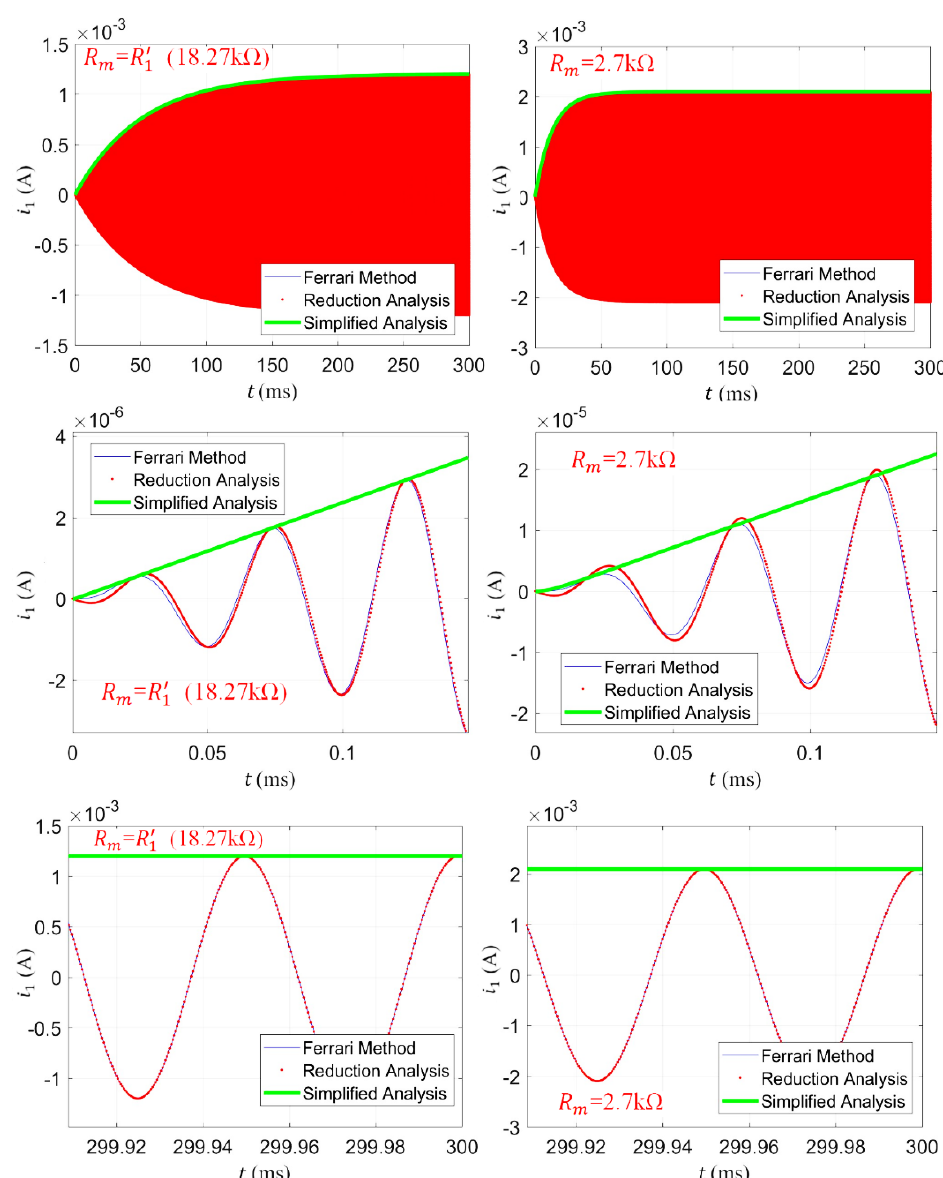
Figure 5. The waveform comparison of the Ferrari method, the reduction analysis and the simplified analysis in two typical over-damping situations, including the details of the start-up and near steady state.